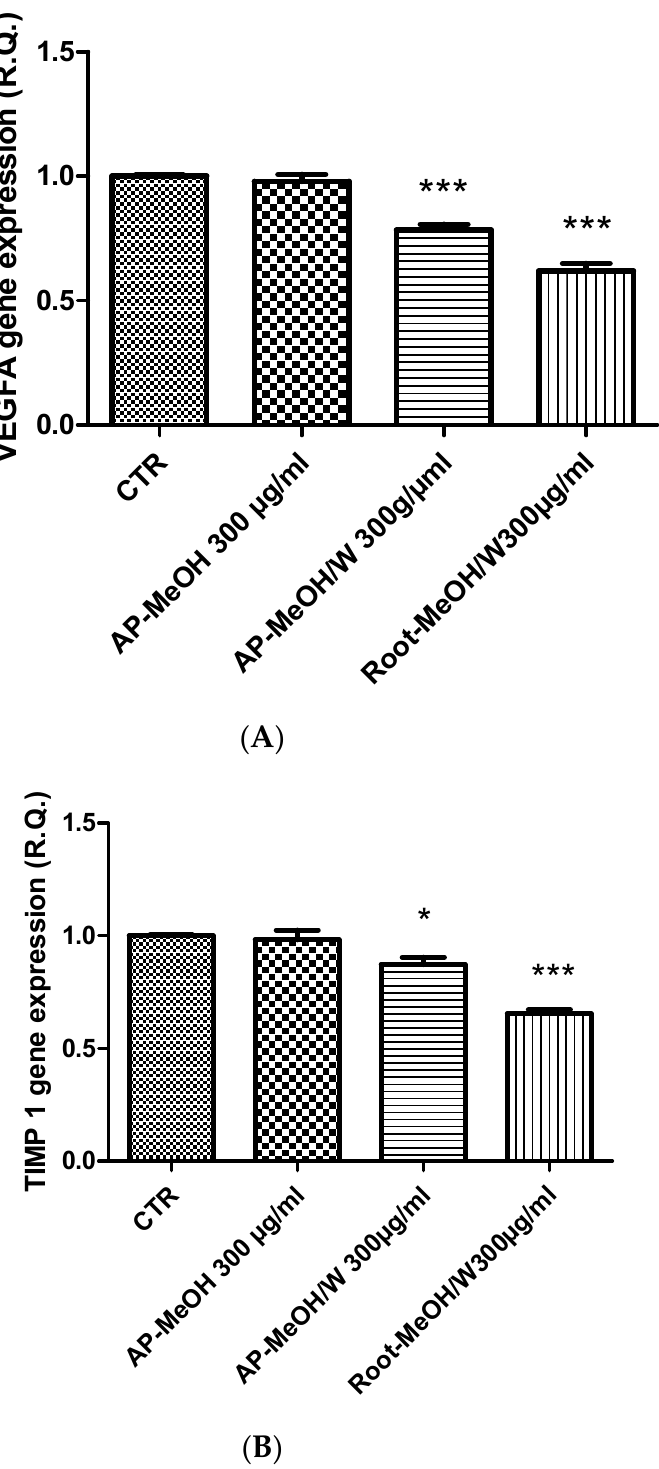
Figure 7. Inhibitory effects of VEGF ( A ) and TIMP1 ( B ) gene expression induced by the methanol (MeOH) and methanol/water (MeOH/W) extracts of aerial parts (AP) and roots from Epilobium hirsutum (100–300 µg/mL). ANOVA, p < 0.0001, *** p < 0.001, * p < 0.05 vs. CTR (Control) group.